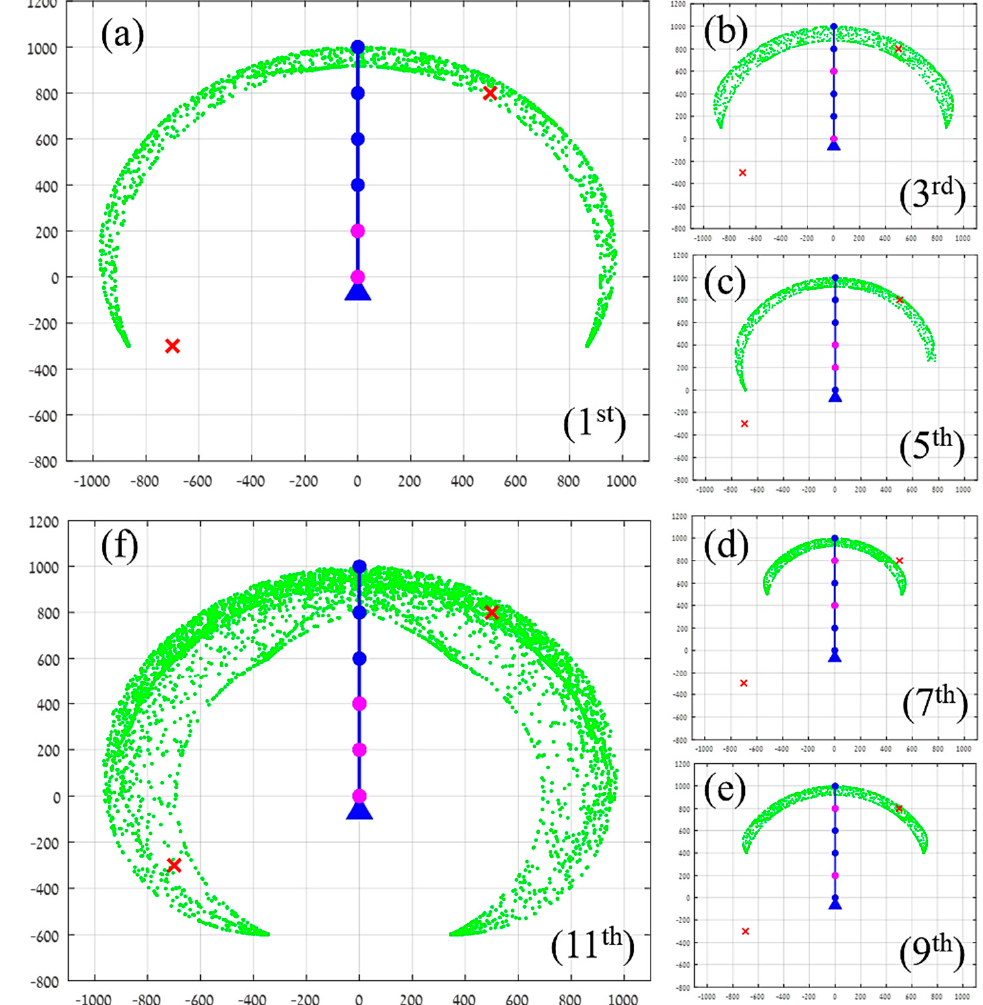
Figure 5. ( a – d ) Last link (LL) workspaces scanned by joint combinations in ascending order. The numbers in the bottom right corners indicate the number of iterations. The highlighted joints were used to compute the workspace. To reach the targets, only the first, second, and third joints are needed; ( e , f ) any link (AL) workspaces, which serve to create a workspace using a single joint ( e ) and cover a larger area ( f ) for the same number of joints as used in the LL method ( d